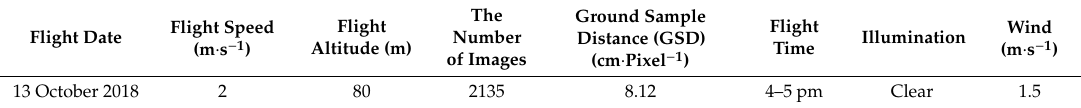
Table 1. Details of UAV flight in this study.